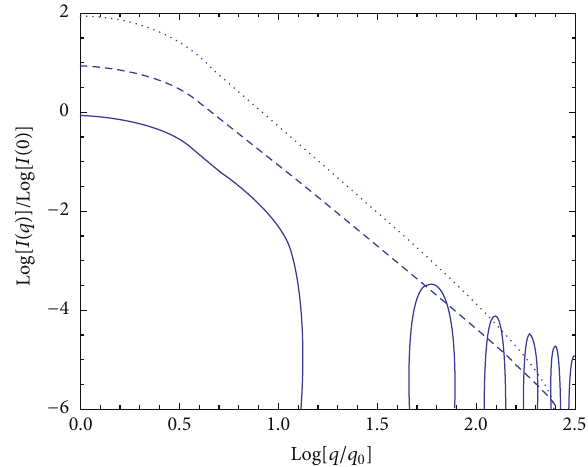
Figure 11: Small-angle scattering intensity of self-similar Boolean models; 𝑞 0 = 1, 𝑟 1 = 1, ] 1 = 0.05, 𝑠 = 1; 𝜅 = 0.001 , and 𝜂 = 2.1 (dotted, curve shifted on the ordinate by 2); 𝜂 = 2.1 (dashed, shifted by 1); 𝜅 = 0.05 , and 𝜂 = 2.5 (solid